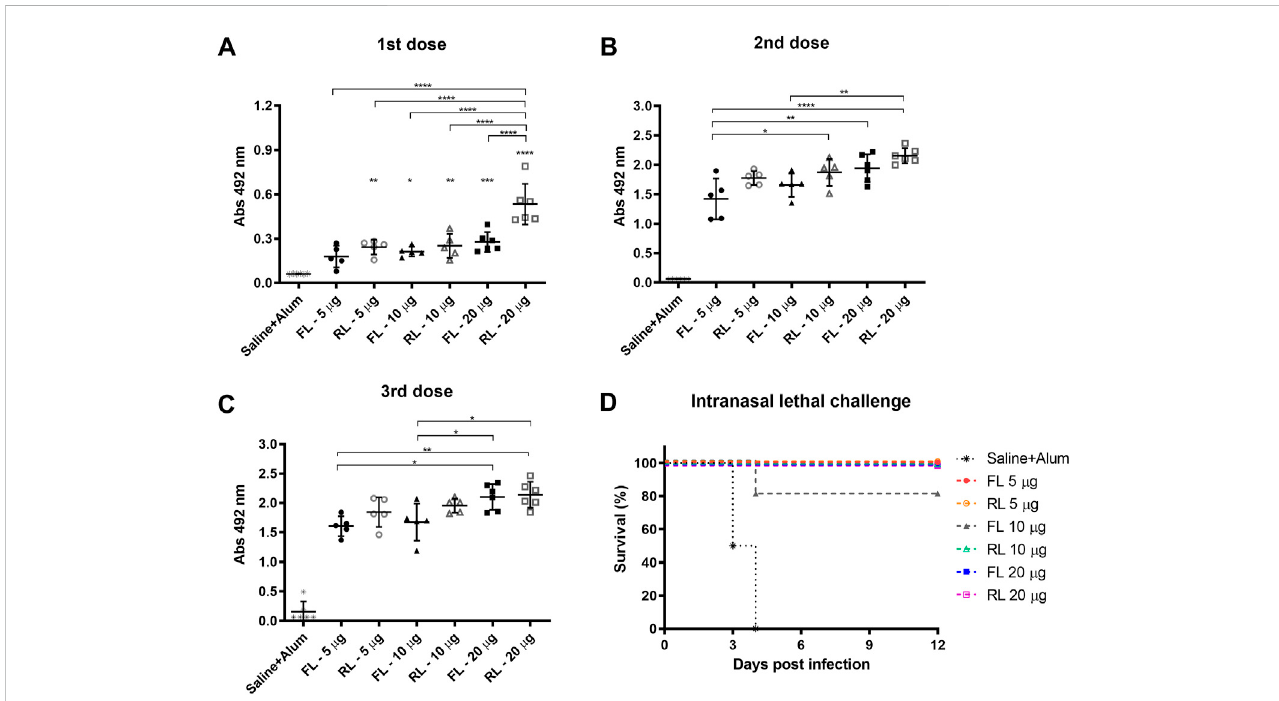
FIGURE 9 Induction of speci fi c IgG anti-rPspA-FL-PdT and anti-rPspA-RL-PdT by subcutaneous immunization and survival curves after pneumococcal intranasal lethal challenge. Mice were immunized with three doses of 5 μ g, 10 μ g or 20 μ g of rPspA-FL-PdT or rPspA-RL-PdT. The animals were immunized with 15- days interval with the indicated masses or control containing only the adjuvant Alum (50 μ g) in saline. Blood was collected 14 days after each immunization and analyzed by ELISA. (A – C) Antibody levels after fi rst, second and third immunization, respectively, are indicated by absorbance at 492 nm of 16,000- fold diluted sera. Statistically signi fi cant differences are indicated (One-way ANOVA, Tukey ’ s Multiple Comparison Test). * p < 0.05, ** p < 0.01, *** p < 0.001, **** p < 0.0001.ForBandC,thedifferenceinrelationtothecontrolgroupisnotindicated,asitpresented p < 0.0001comparedtoallothergroups. (D) Survival curves of mice after intranasal lethal challenge with S. pneumoniae strain A66.1. Five immunized groups showed 100% of protection, and one immunized group showed 80%. Animals were challenged with 1 × 10 5 CFU intranasally 21 days after the third dose. Curves were analyzed by the Log-rank test